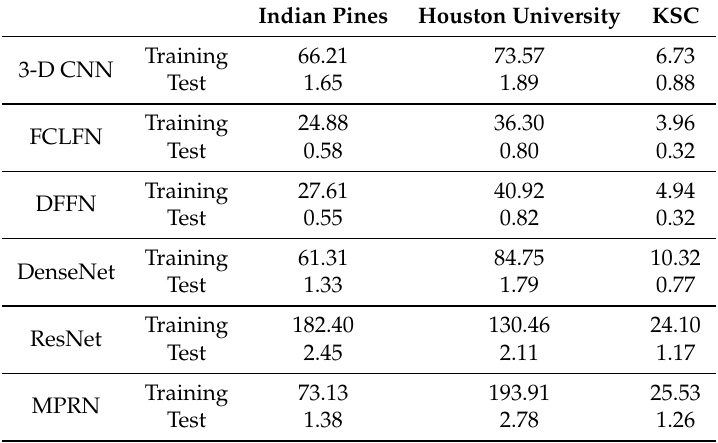
Table 9. Running time (in second) of different methods on the three data sets.